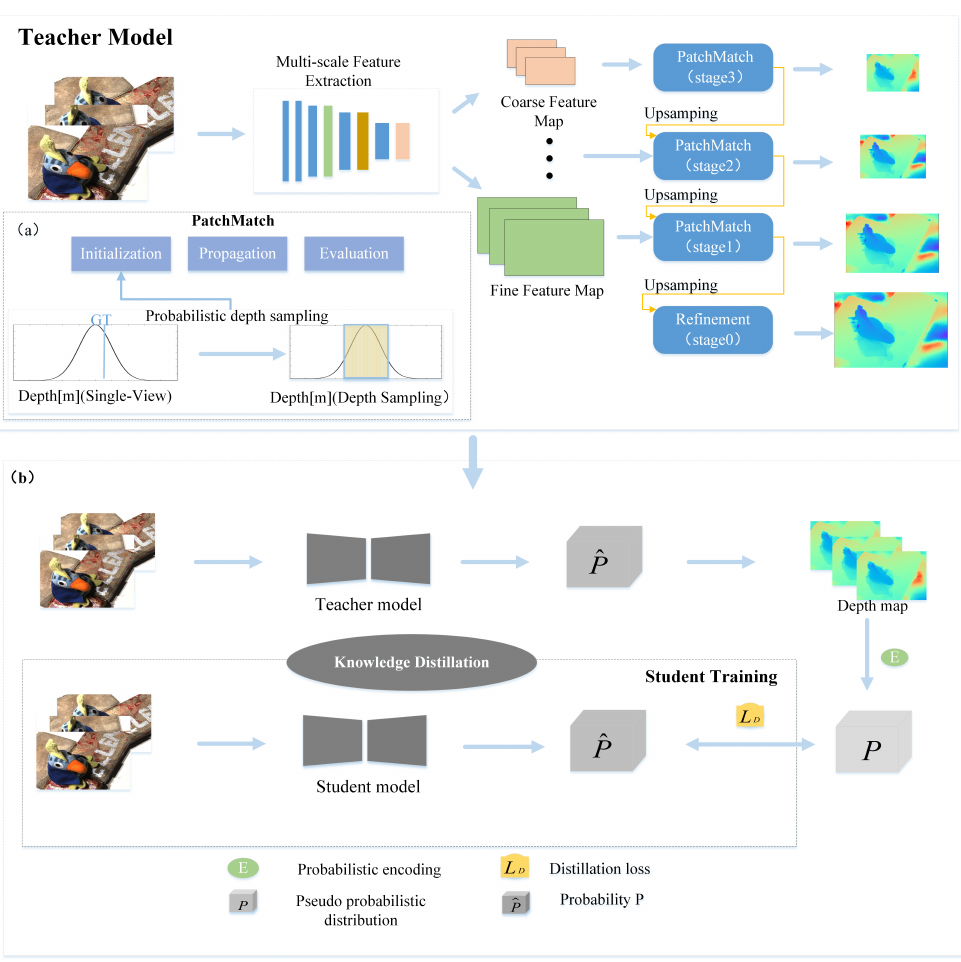
Figure 1. The framework of KD-PatchMatch, including PatchMatch-based MVS framework and self-supervised training pipeline based on knowledge distillation: ( a ) This figure illustrates how the depth candidates are sampled during the depth initialization phase, The curves and shadows represent the estimated depth probability distributions and depth sampling range during the depth initialization phase. ( b ) The pipeline for self-supervised training based on knowledge distillation is shown in this image, along with the creation of pseudo-probabilistic knowledge and student